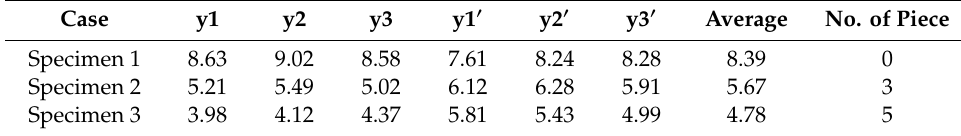
Table 3. Experimental results of maximum displacements in y-direction